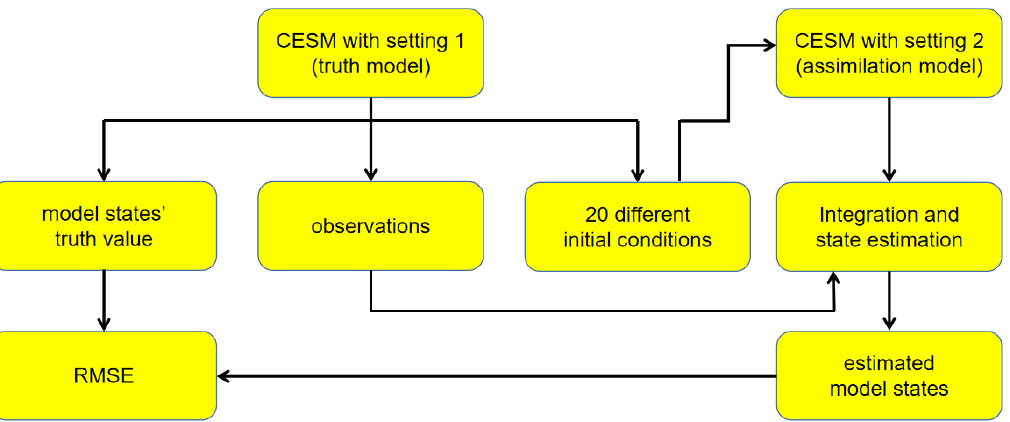
Figure 2. A schematic diagram of the assimilation process framework based on EAKF method in OSSE.